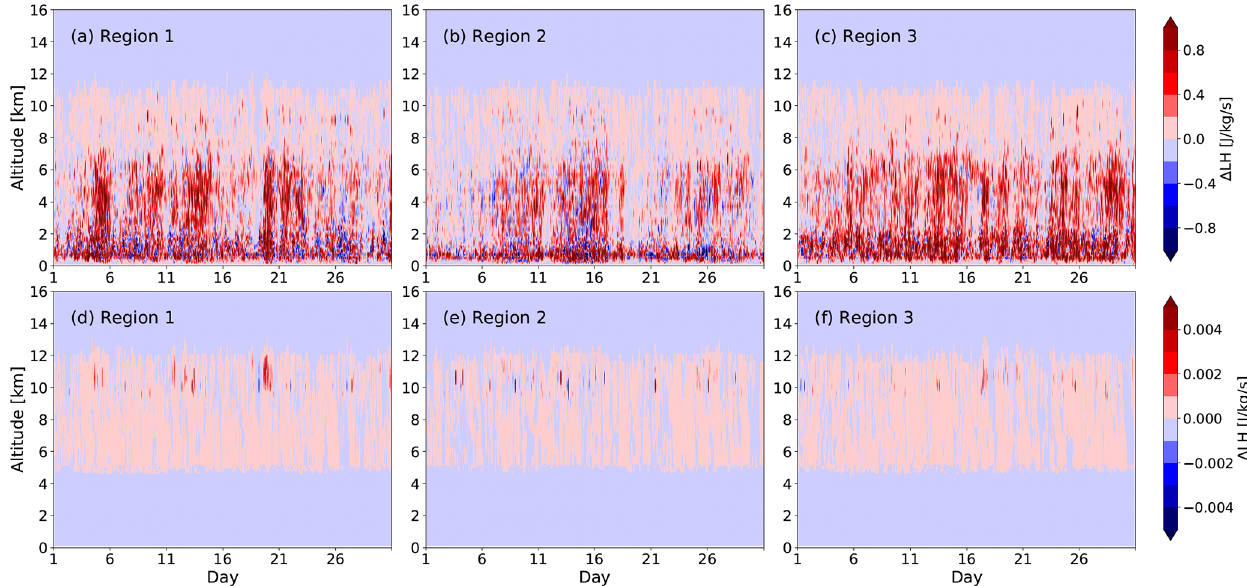
Figure A3. Differences (FIRE − NOFIRE) in the estimated rate of maximum latent heat release (Jkg − 1 s − 1 ) following (a, b, c) droplet activation and (d, e, f) droplet freezing in (a, d) Region 1, (b, e) Region 2, and (c, f) Region 3. These were estimated from newly activated droplet number concentration (kg − 1 ), time step (s), droplet freezing rate (kg − 1 s − 1 ), and cloud droplet and ice effective radii r c and r i . Since newly formed droplets and ice crystals are typically smaller than r c and r i , respectively, these are the maximum estimates. Note the difference in the scale of the color